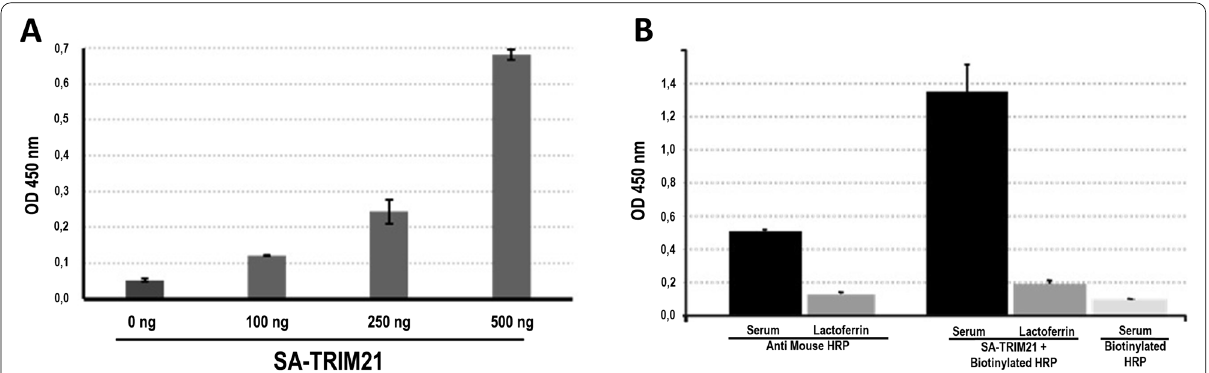
Fig. 2 SA-TRIM21 functional assays. A The performance of streptavidin domain: SA-TRIM21 (0–500 ng) was coated into polystyrene plates followed by detection using Biotin-HRP (1:2500). B Detection of immobilized mouse serum. Mouse serum (50 ng) was coated onto polystyrene plates and detected using HRP-coupled anti-mouse IgG (Sigma, 1:10.000) or 500 ng SA-TRIM21 followed by incubation with biotinylated HRP (dil:1:2500). Control experiments were performed using mouse IgG and biotinylated HRP in the absence of SA-TRIM21. Experiments were performed in triplicates, and error bars represent standard deviation. A , B Wells were washed with PBST, 50 μL chromogenic substrate TMB was added to the wells, incubated for 10 min, followed by the addition of 50 μL H 2 SO 4 to quench the reaction followed by OD 450 nm reading using an ELISA plate